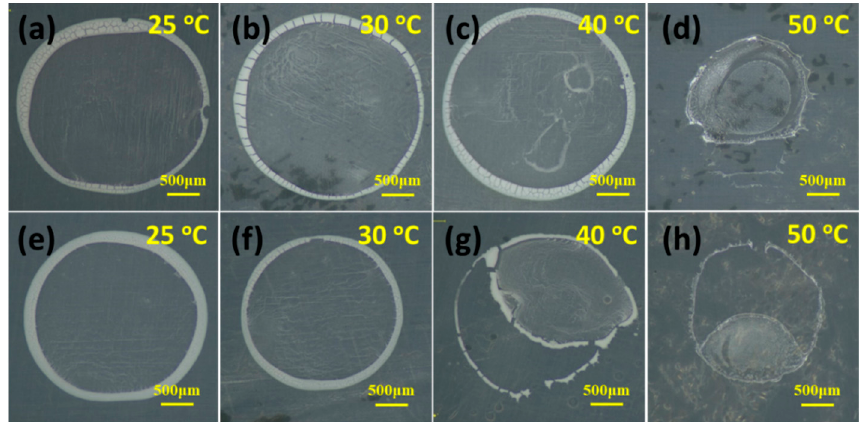
Figure 5. Optical microscope observation of ( a – d ) 20-TIPS + DE samples and ( e – h ) 60-TIPS + DE samples at different evaporation